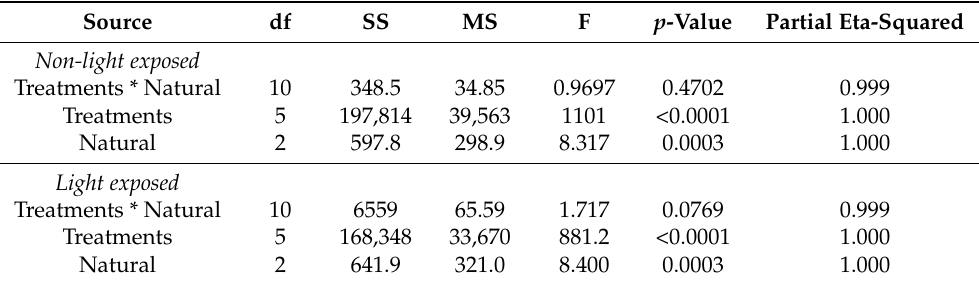
Table 5. Summary of two-way ANOVA results for oral keratinocytes viability non-exposed and exposed to light. The analyzed variables were natural substances (“Natural”) and exposure to light